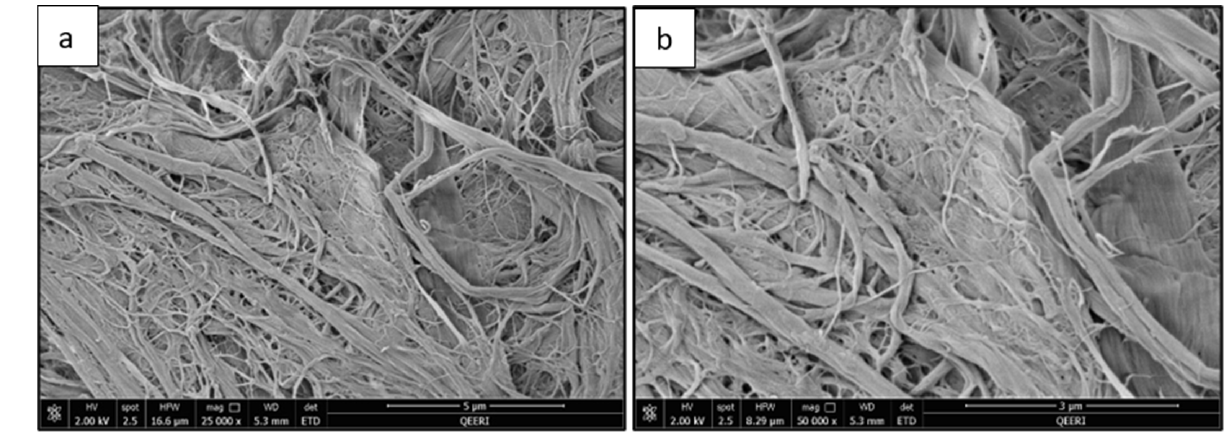
Figure 2. SEM images of CNF at ( a ) 5 µm and ( b ) 3 µm scale.